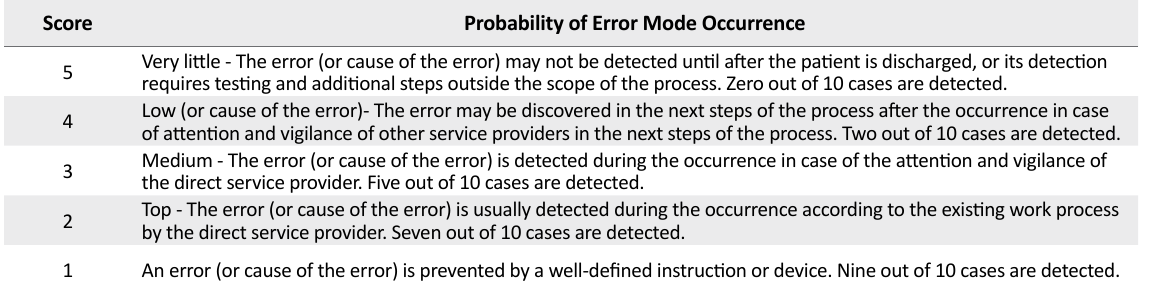
Table 3. Ranking of the error detection rate capability